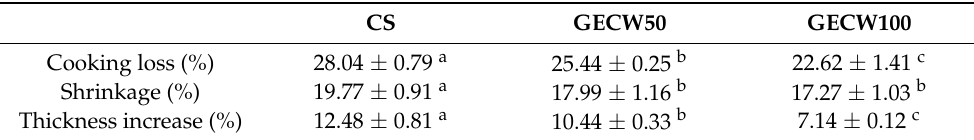
Table 5. Cooking characteristics of beef burger elaborated with cocoa bean shell flour and walnut oil emulsion gel as partial and total pork backfat